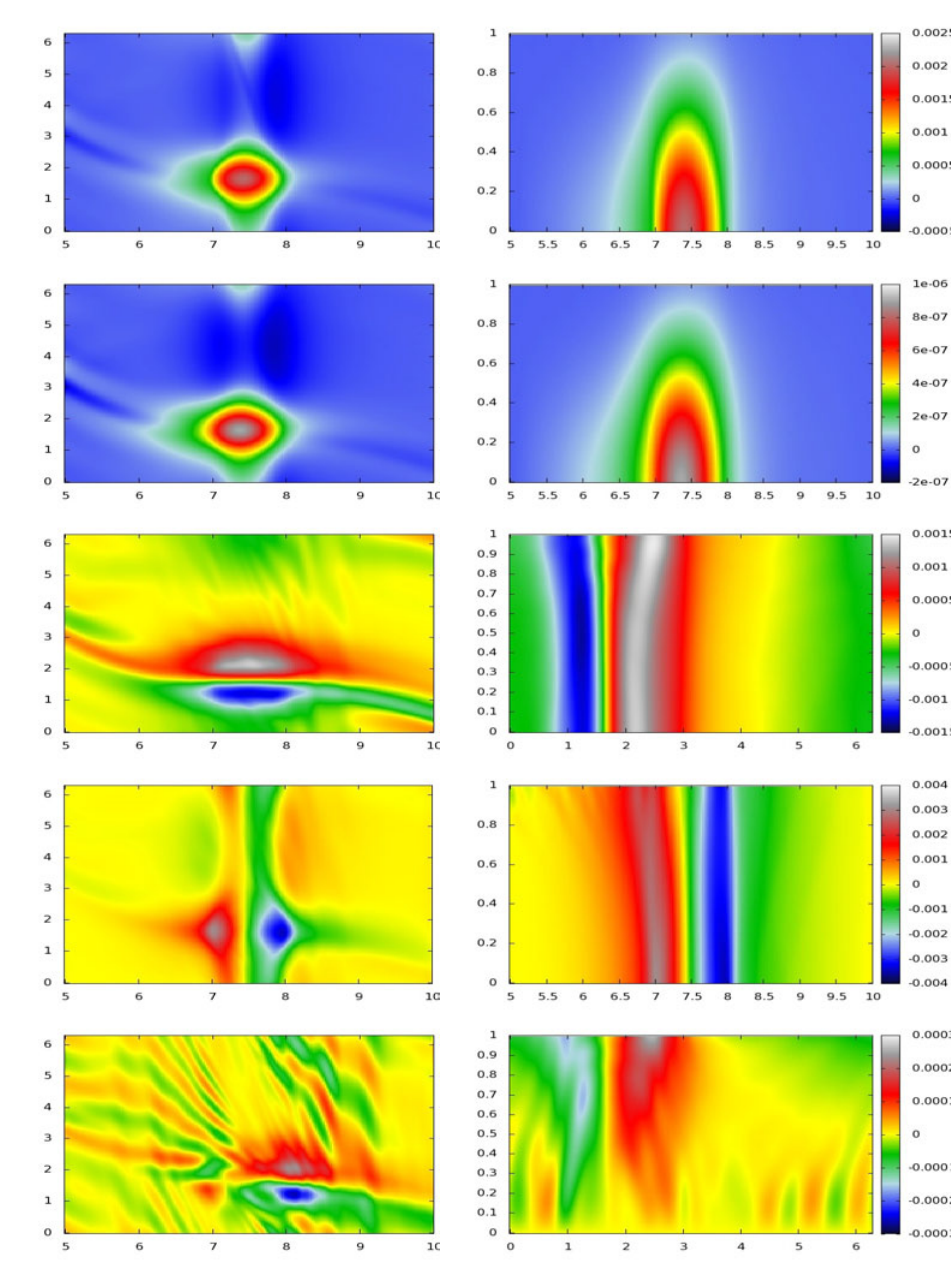
Figure 1. Three-dimensional structure of the vortex. From top to bottom the five rows represent: the density, the pressure, the radial velocity, the azimuthal velocity and the vertical velocity, respectively. The left column displays the values in the equatorial plane except for the vertical velocity which is displayed in the ( r − θ ) plane at z = 0 . 5. The right column displays vertical profiles in the plane ( r − z ; θ = 2 . 67), except the third and fifth rows which display the radial and azimuthal velocities in the plane ( θ − z ; r = 7 . 5), respectively.